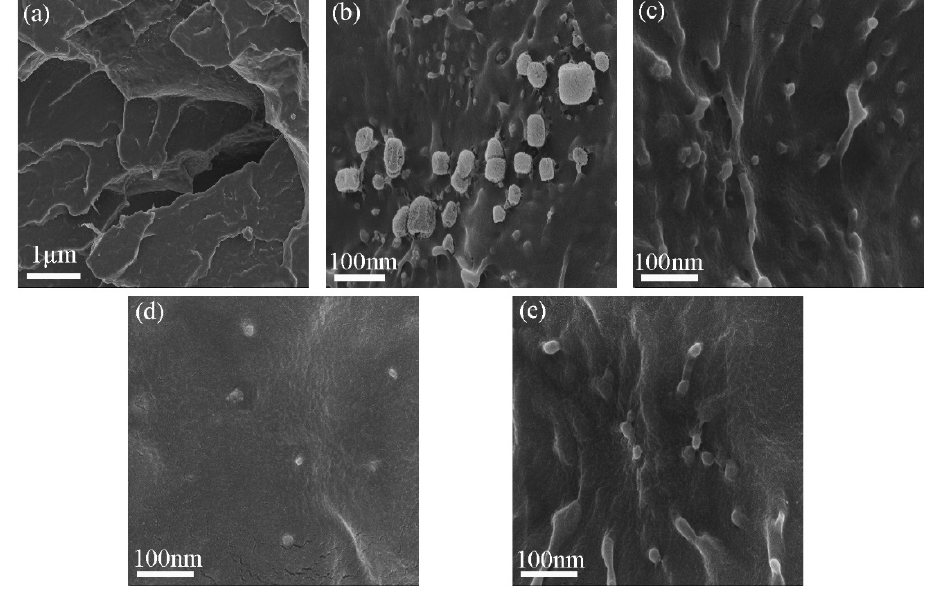
Figure 4. SEM image of freeze fractured samples ( a ) neat PBS, ( b ) R-PBS, ( c ) A-PBS, ( d ) V-PBS, and ( e ) P-PBS.